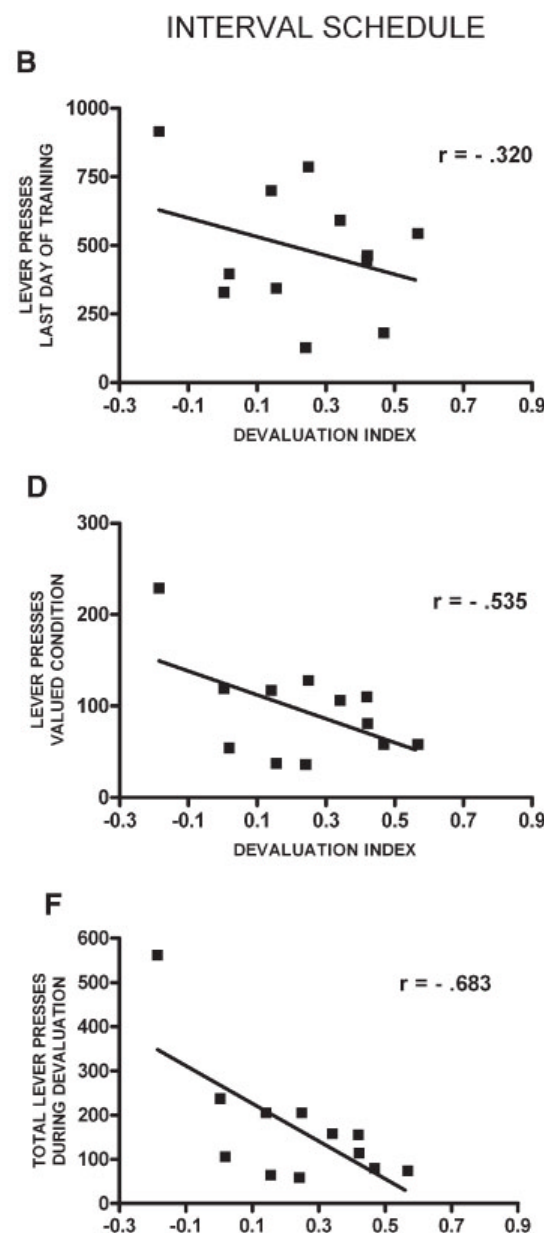
p <0.001), ( Figure 4A ). Random ratio-trained animals pressed signifi- cantly more on the lever that was reinforced during training than on the novel lever ( t 7 = 4.35, p <0.001, Figure 4B ). However, random interval- trained animals pressed the novel lever as much as the training lever ( t 7 = 1.23, p = 0.26). The normalized data confirmed that the random ratio group pressed mostly on the training lever ( t 7 = 3.88, p <0.01), while the random interval group explored the novel lever as much as the training lever ( t 7 = 0.62, p = 0.56), ( Figure 4C